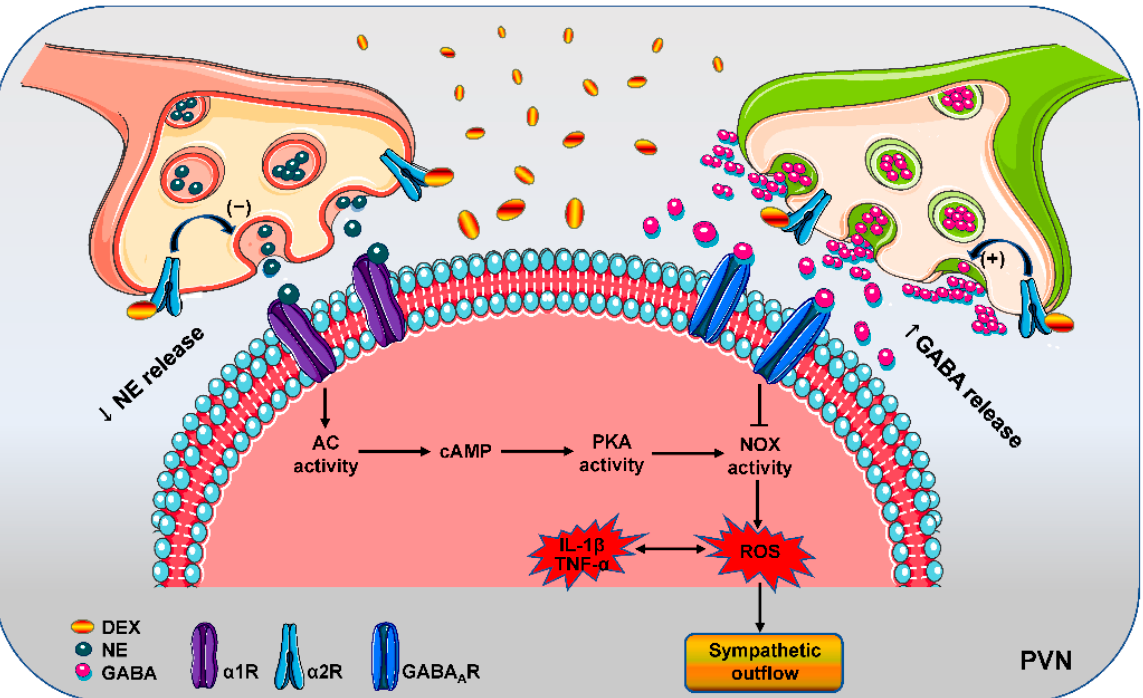
Figure 9. Schematic diagram showing the roles of DEX in the PVN in regulating sympathetic activ- ity. Abbreviations: AC, adenylate cyclase; DEX, dexmedetomidine; GABA A R, type A γ -aminobu- tyric acid receptor; IL-1 β , interleukin-1 β ; NE, norepinephrine; NOX, NADPH oxidase; PKA, protein kinase A; PVN, paraventricular nucleus; ROS, reactive oxygen species; TNF- α , tumor necrosis fac- tor- α ; α 1R, α 1 adrenergic receptor; α 2R, α 2 adrenergic receptor.